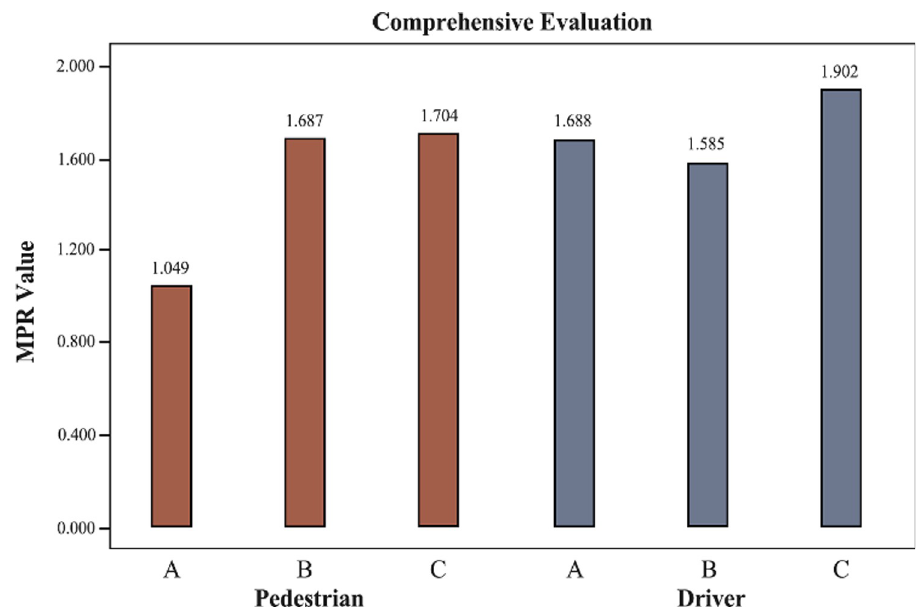
Fig 6. Comprehensive evaluation